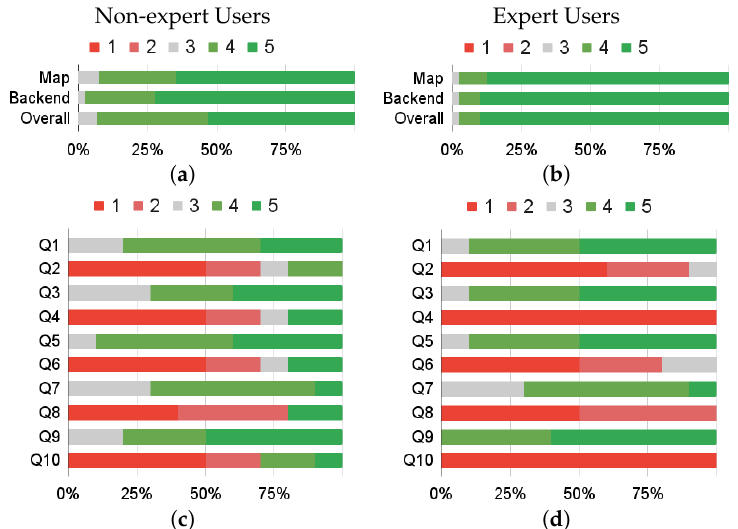
Figure 6. The first row represents the results of task-driven assessment (TDS) for non-expert ( a ) and expert ( b ) users. The second row shows the SUS assessment for non-expert ( c ) and expert ( d ) users. For TDS and odd questions of SUS, the higher, the better. For even questions of SUS, the lower, the